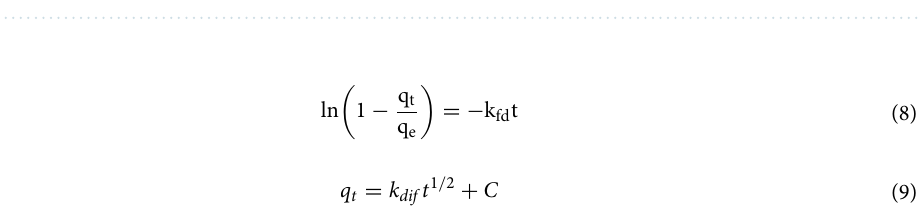
Table 1. Fitting of experimental data with theoretical kinetics models. Fitting of different kinetic models for adsorption of DCF on